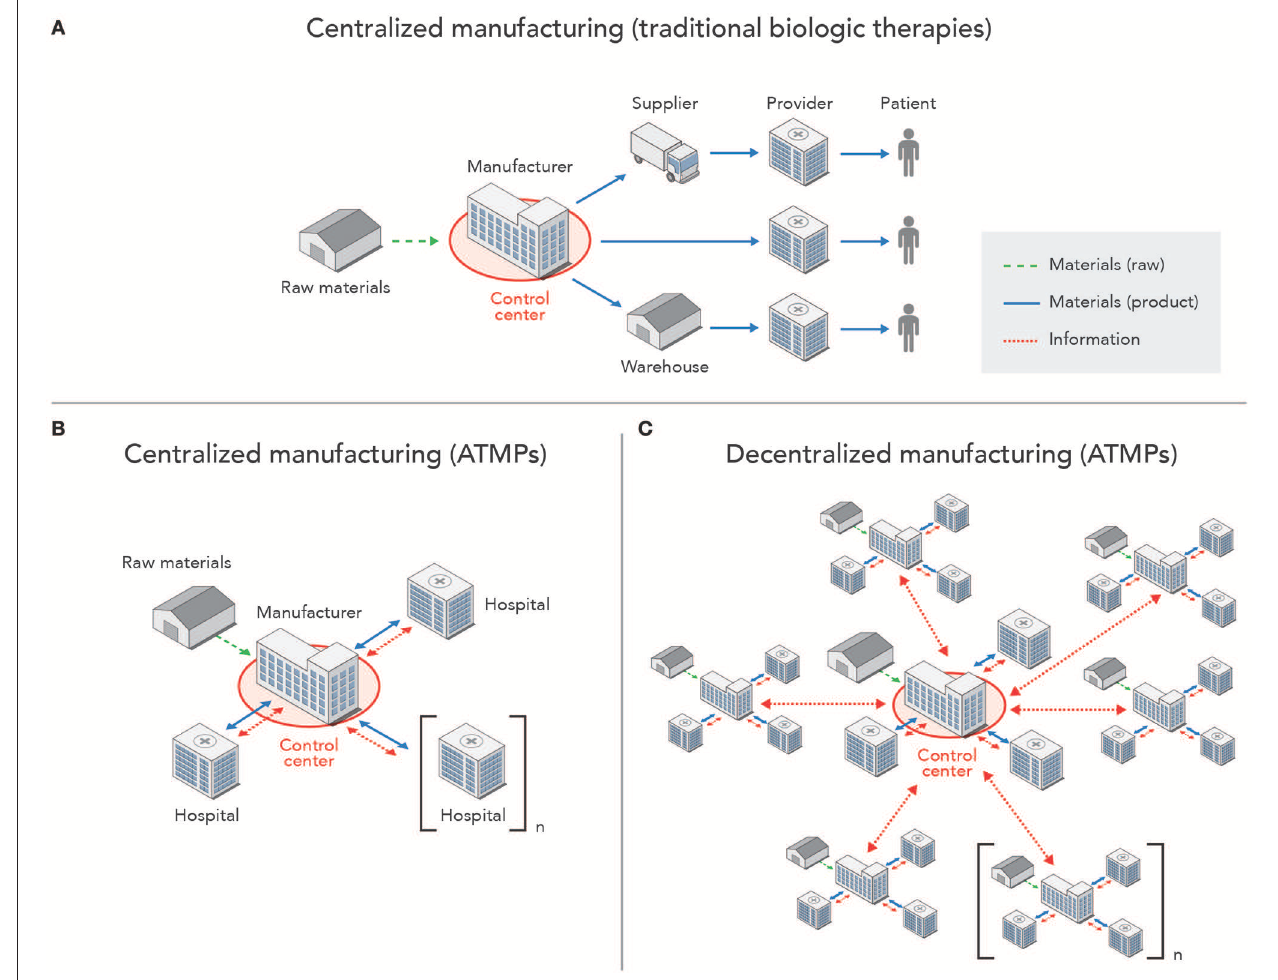
FIGURE 2 | High-level representation of information flow, including raw materials and finished products, across a network of manufacturing sites, patient providers, and control centers for monitoring of SCADA systems. (A) Centralized manufacturing of traditional biologic products, such as monoclonal antibodies as indicated in Figure 1 , with a unidirectional flow of materials from the manufacturing facility to providers (e.g., pharmacies, hospitals, retailers), while information on the product is tracked across the supply chain, and a control center is housed within the facility. (B) Centralized manufacturing of ATMPs, which requires information and material exchange with each patient found in one or more hospitals, while the control center is still housed within the manufacturing facility. (C) Decentralized production of ATMPs with multiple manufacturing sites that each interface with a control center (located within one of the manufacturing facilities in the network or standalone) that monitors and manages the SCADA systems found in each